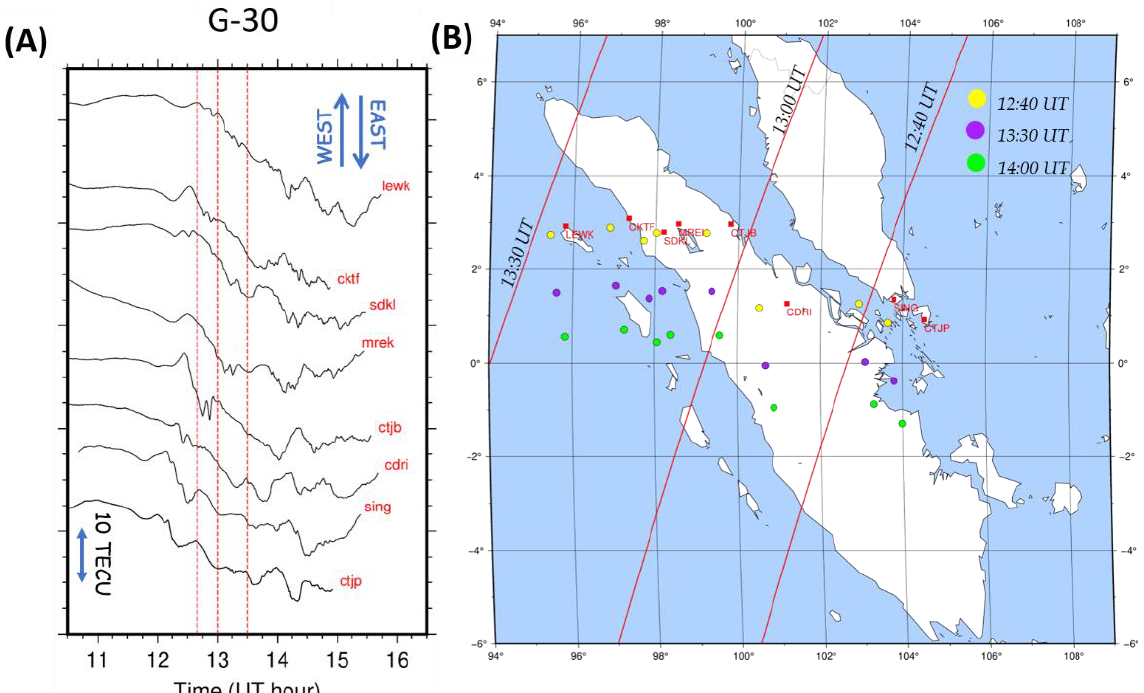
Figure 3. ( A ) Time series of VTEC from G30 satellite on 15 January 2022, at eight GNSS stations in Sumatra and nearby islands. They show significant disturbance signatures, reflecting passages of LW from the HTHH volcano. Red broken lines correspond to times for which wavefronts of LW are given in the map. ( B ) A map showing the station positions, and SIPs (coloured circles) and LW wavefronts (red lines) at three epochs shown with vertical lines in ( A ).